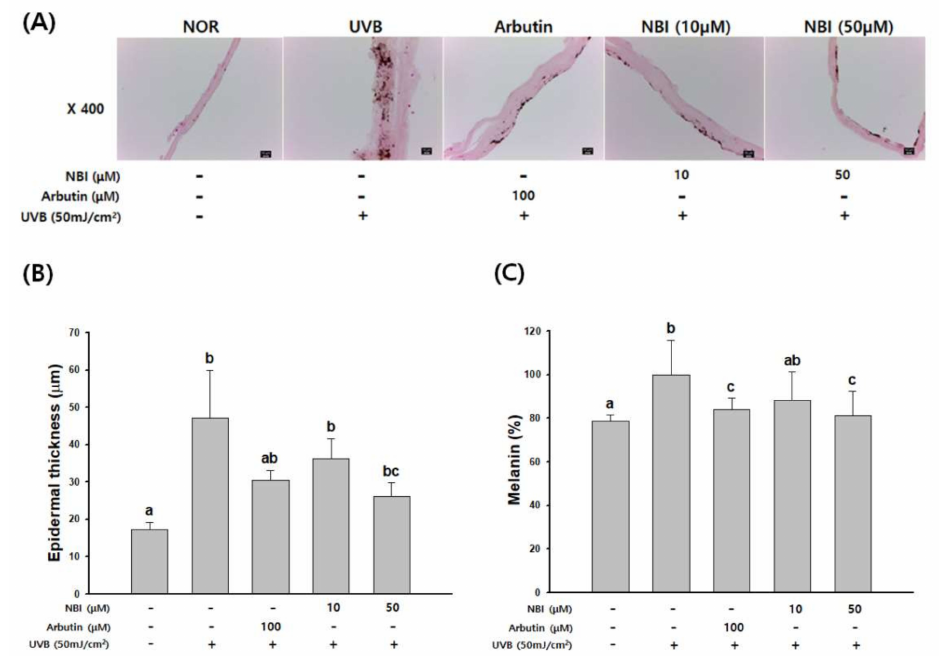
Figure 9. The inhibitory e ff ect of NBI on melanin production in a reconstructed human 3D skin model skin model. ( A ) Fontana-Mason (F-M) staining of tissue sections. ( B ) Measurement of epidermal thickness. ( C ) Melanin content in a reconstructed human 3D skin model. Data are presented as mean ± SD. Values with di ff erent letters (a, b, c) are significantly di ff erent one from another (one-way ANOVA followed by Tukey’s multiple range test, p <